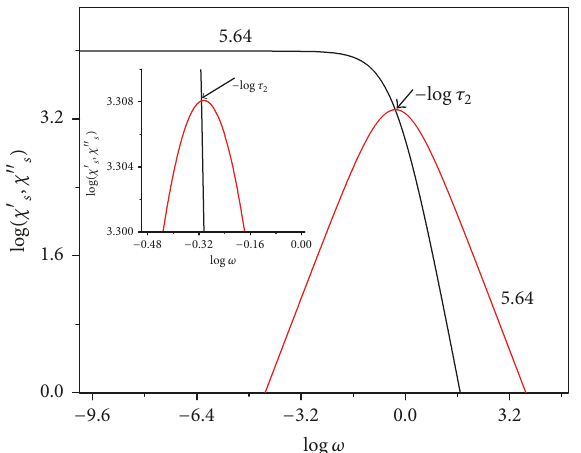
Figure 1: Frequency dependence of 𝜒 𝑠 (𝜔) in the paramagnetic phase. The number accompanying each curve is the value of the reduced temperature while 𝑟 = 1.0 , 𝐻 𝑟